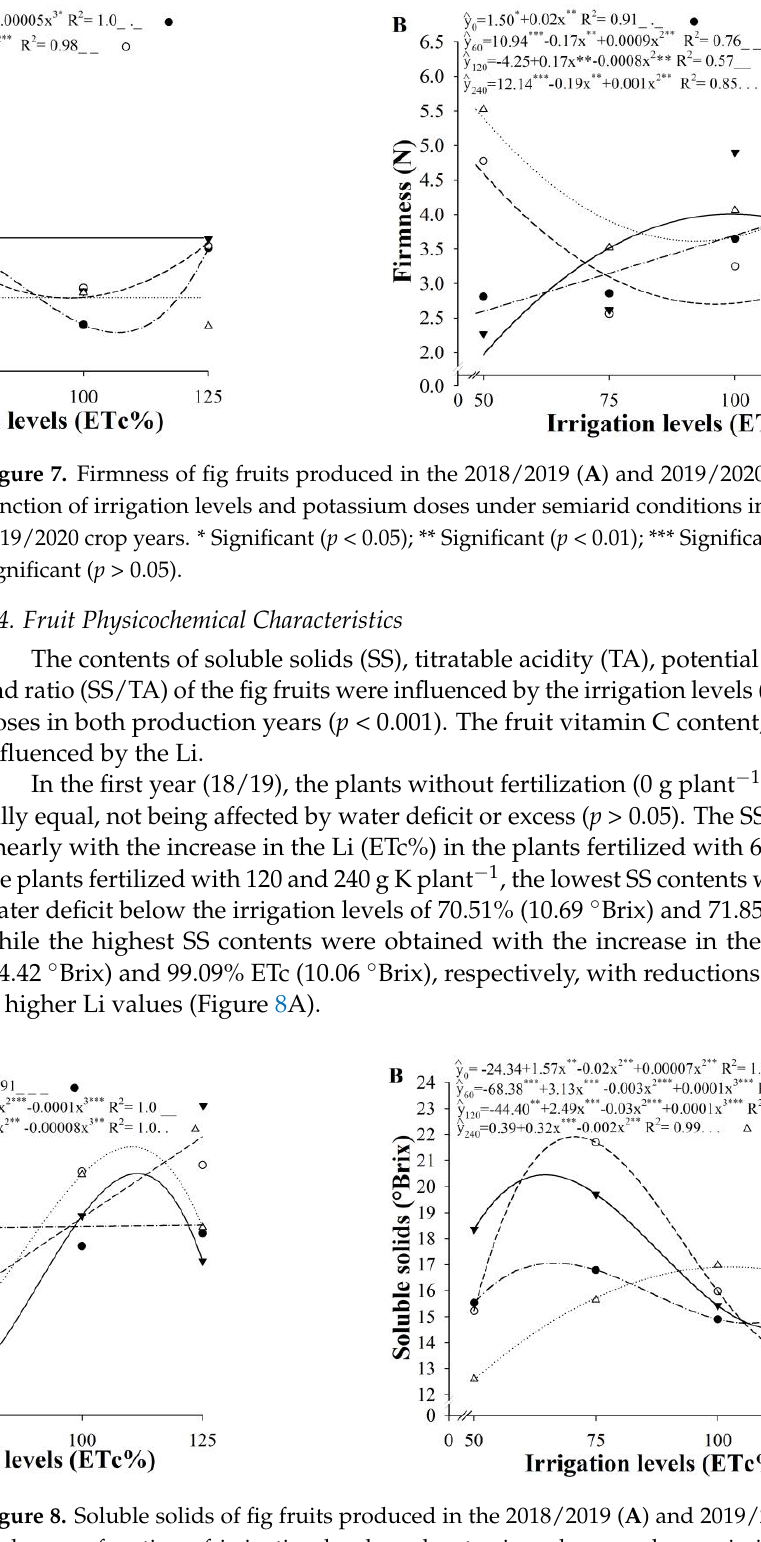
10 of 17 Figure 6. Lightness (L*) ( A ) and hue angle (°Hue) ( B ) of fruits as a function of the irrigation levels in fig plants grown under semiarid climatic conditions in the 2018/2019 and 2019/2020 crop years. ns Not significant ( p > 0.05); *** ( p < 0.001).